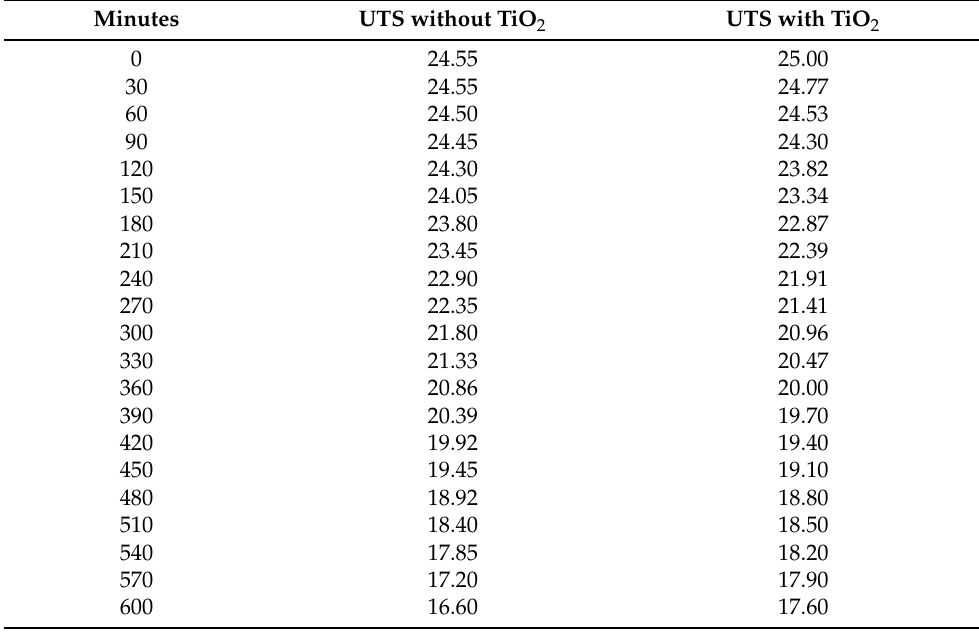
Table 1. Ultimate tensile strength (UTS) value (in Newtons) of polypropylene fibers as a function